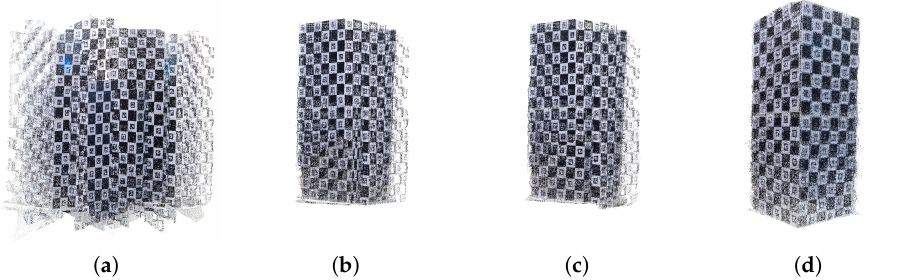
Figure 13. Calibration and registration result of the Charuco box ( a ) before calibration, ( b ) after 15 frames, ( c ) after 21 frames, ( d ) 30